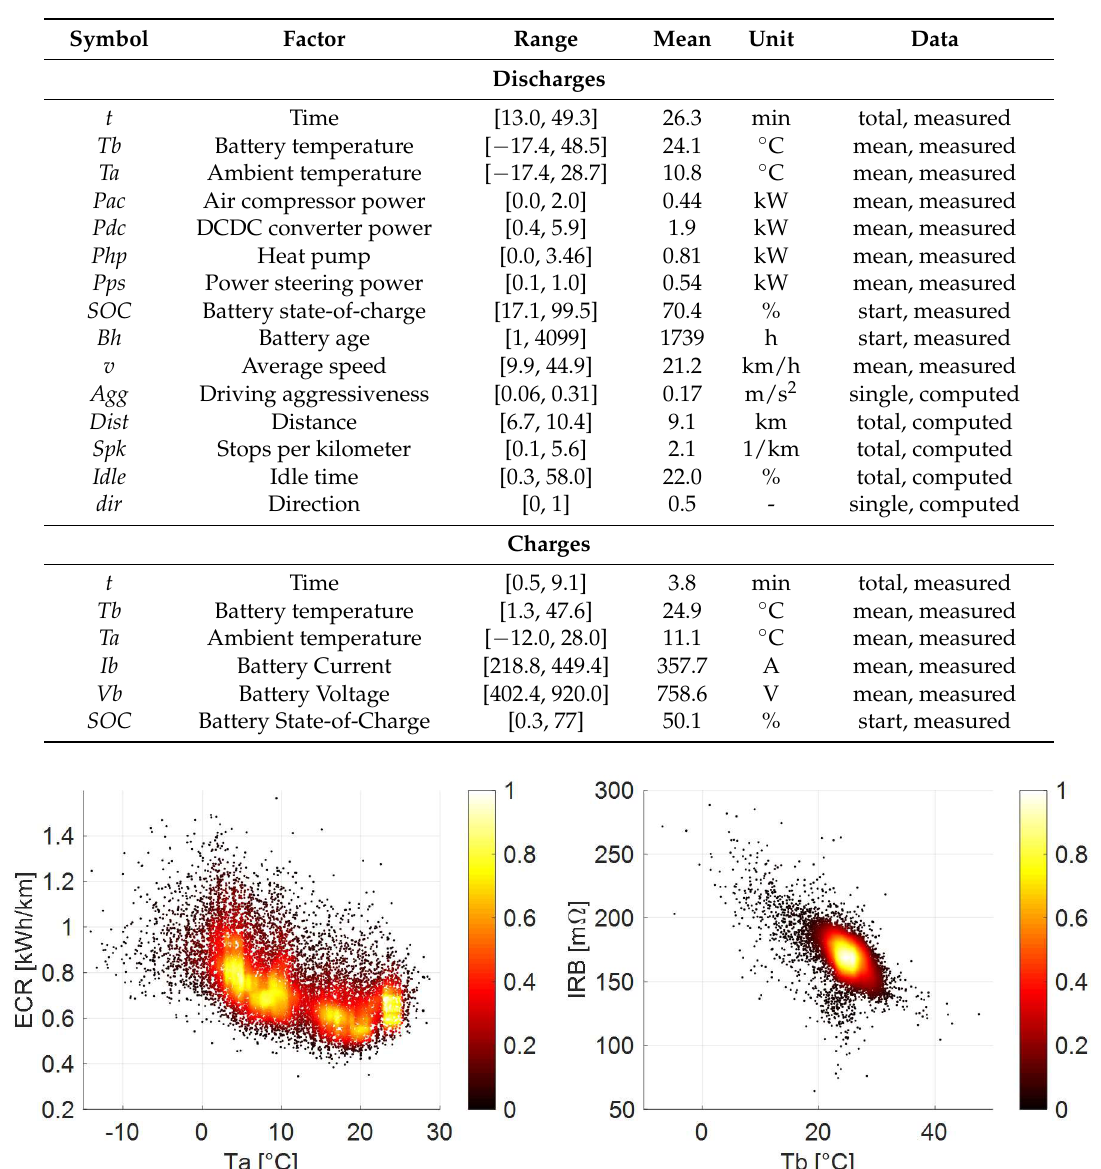
Table 2. The symbol, range, mean, unit, and measured value of each operation factor.